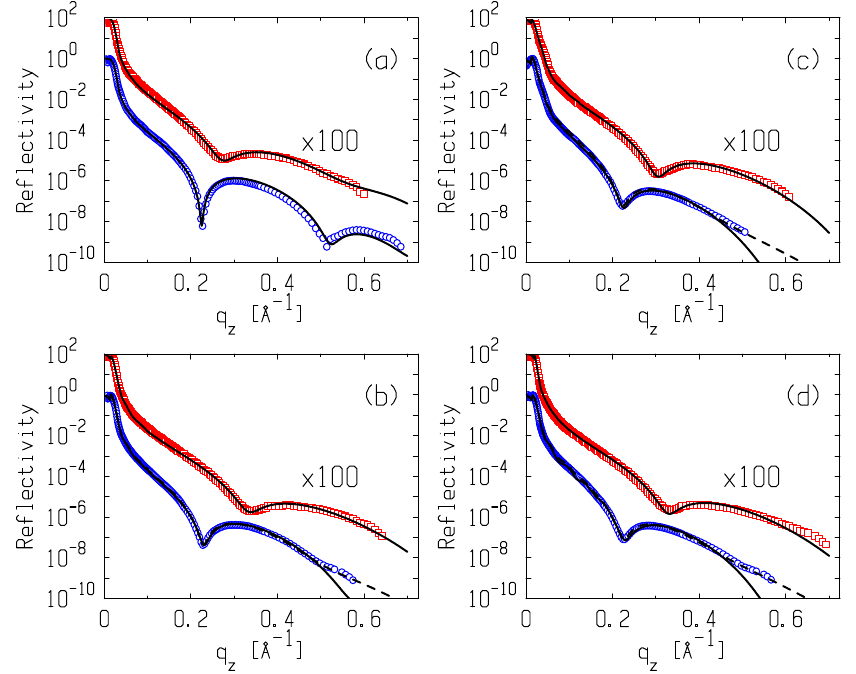
Figure 4. X-ray reflectivity, R ( q z ), for DMPS monolayers at the surface of water subphase and in the presence of polylysines at the area per lipid: A ≈ 40 Å 2 (blue circles; LC phase near the collapse) and A ≈ 70 Å 2 (red circles, LE phase). Panels correspond to the surface of the 10 mM KCl water subphase ( a ) and water solutions of PL-5 ( b ), PL-12 ( c ), and PL-200 ( d ), respectively. Error bars (in a range from 3% to 10%) representing the counting statistics for the datapoints are smaller than the symbols. Solid and dashed lines correspond to the model structures discussed in the text.